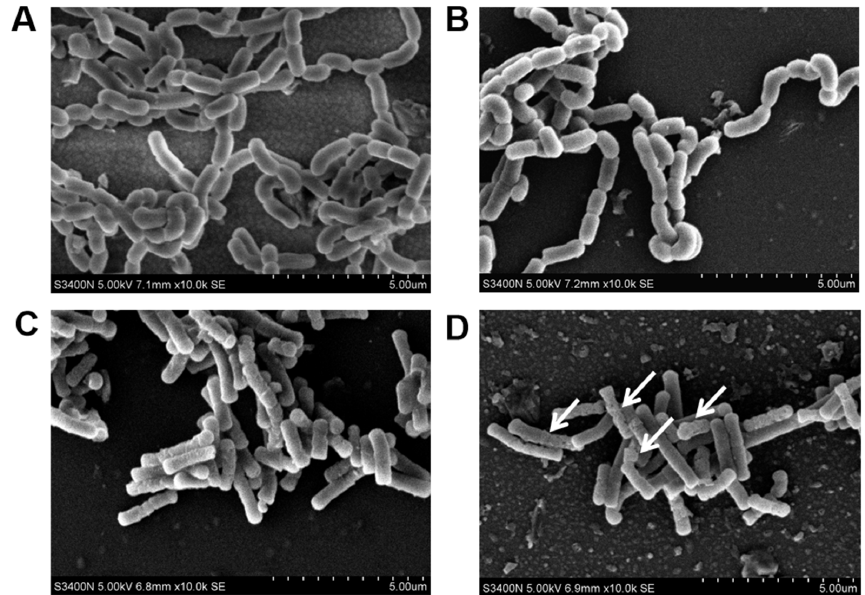
Figure 7. SEM photographs of bacterial cells at a magnification of 10,000 × : ( A ) L. paracasei 85 without ZEN treatment; ( B ) L. paracasei 85 with ZEN treatment; ( C ) L. buchneri 93 without ZEN treatment; ( D ) L. buchneri 93 with ZEN treatment (the damage positions are marked with white arrows).